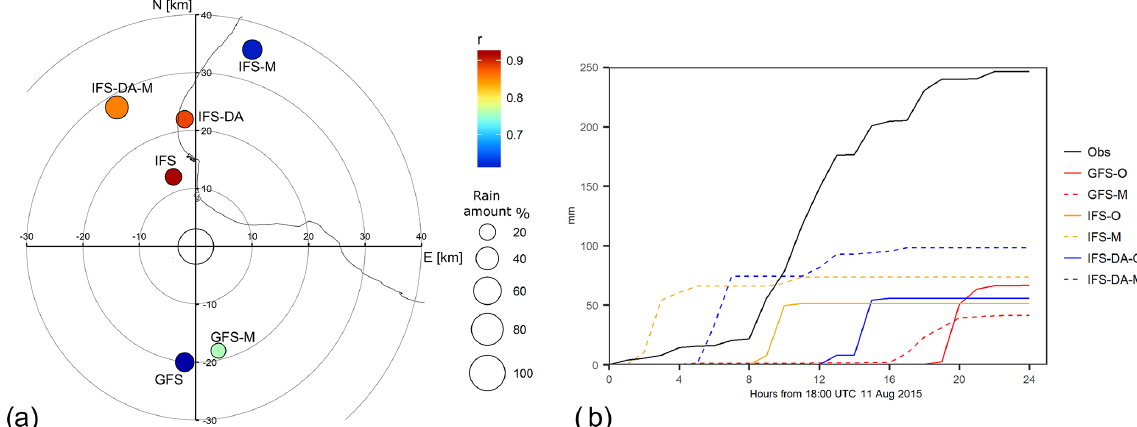
Figure 7. Circles in panel (a) are located at the peaks highlighted in Fig. 6 for each of the different configurations; the colours indicate the time correlation, whereas the size refers to the percentage rain amount with respect to Corigliano observations. (b) Temporal accumulated rainfall (mm) observed at Corigliano and simulated by the different peaks.